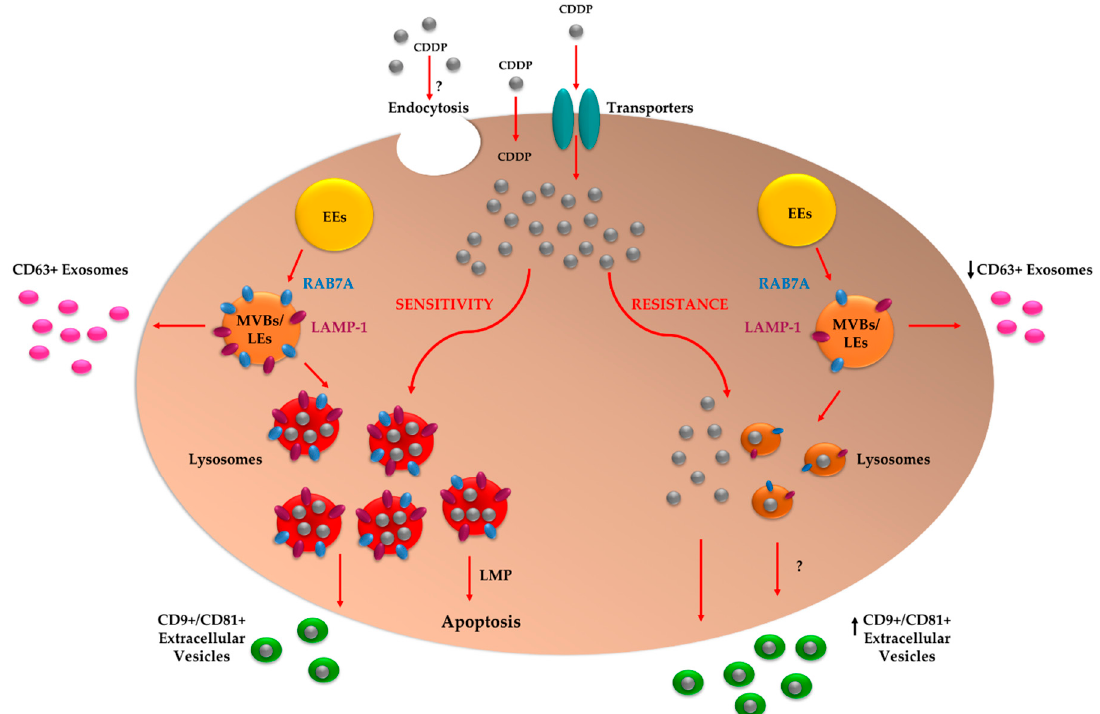
Figure 5. Proposed chemoresistance mechanism mediated by RAB7A. CDDP enters the cell through specific transporters, by passive diffusion or by endocytosis. The uptake of CDDP in cells with functional endocytic trafficking leads to activation of apoptosis following sequestration of drug in lysosomes and consequent Lysosomal Membrane Permeabilization (LMP) induction. Uptake of CDDP into cells in which RAB7A is downregulated with a reduction in the size, number and acidification of lysosomes, leads to CDDP efflux through the EVs and then to a resistant phenotype. EE: Early Endosome; LE: Late Endosome; MVB: Multivesicular Body.